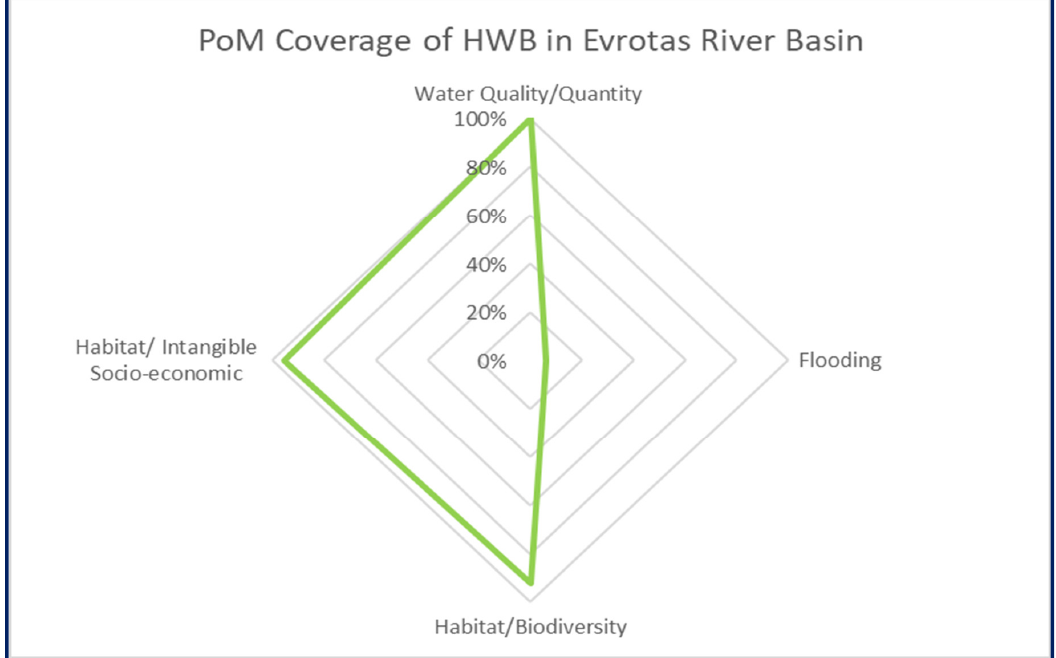
Figure 7. The coverage of HWB factors within the Evrotas River Basin.